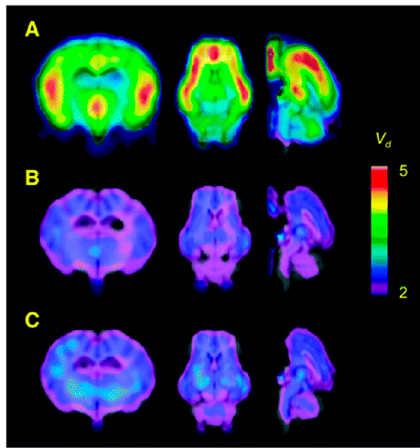
Figure 4. Parametric maps of 16 in living porcine brain. ( A ) Baseline study using 16 showed regional differences in its distribution. ( B ) Blocking experiment (yohimbine at 0.07 mg/kg) reduced the scale of distribution volume ( V d ) to ~2 mL g − 1 in all the α 2-AR bound regions. ( C ) Increased dose of yohimbine (1.6 mg/kg) had no further significant effect in comparison to the low dose ( n = 3) Maps are superimposed on the MR image. Adapted from JNM publication by Jacobsen S, Pedersen, K.; Smith, D.F.; Jensen, S.B.; Munk, O.L.; Cumming P [97] . Permission obtained from SNMMI.